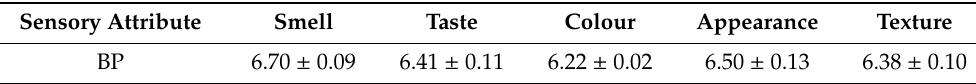
Table 6. Results of dried banana sensory